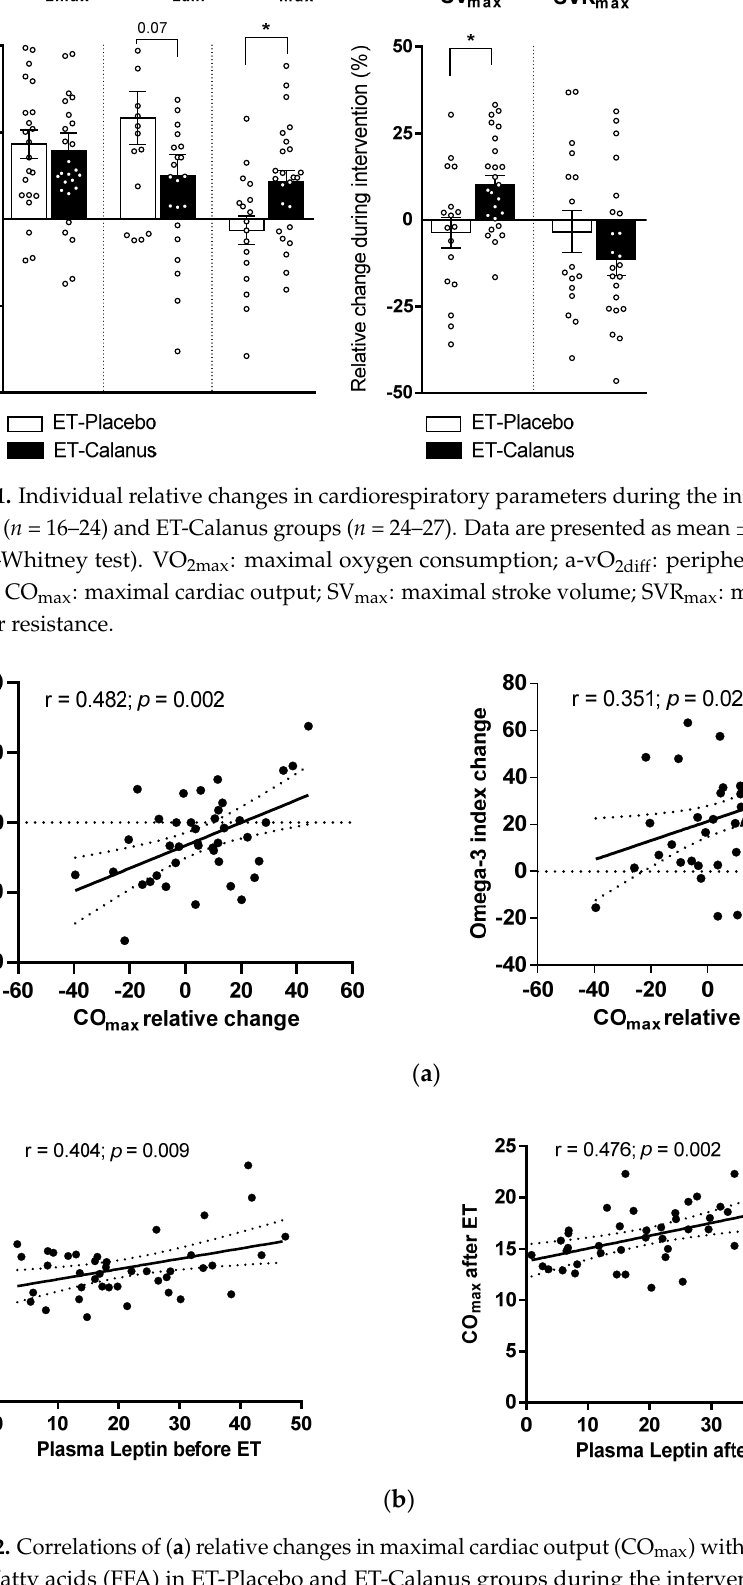
changes in free fatty acids (FFA) in ET-Placebo and ET-Calanus groups during the intervention; ( b ) CO max with plasma leptin levels before and after the intervention in all subjects. The Pearson’s correlation coefficient is presented (ET-Placebo, n = 16; ET-Calanus group, n = 24).